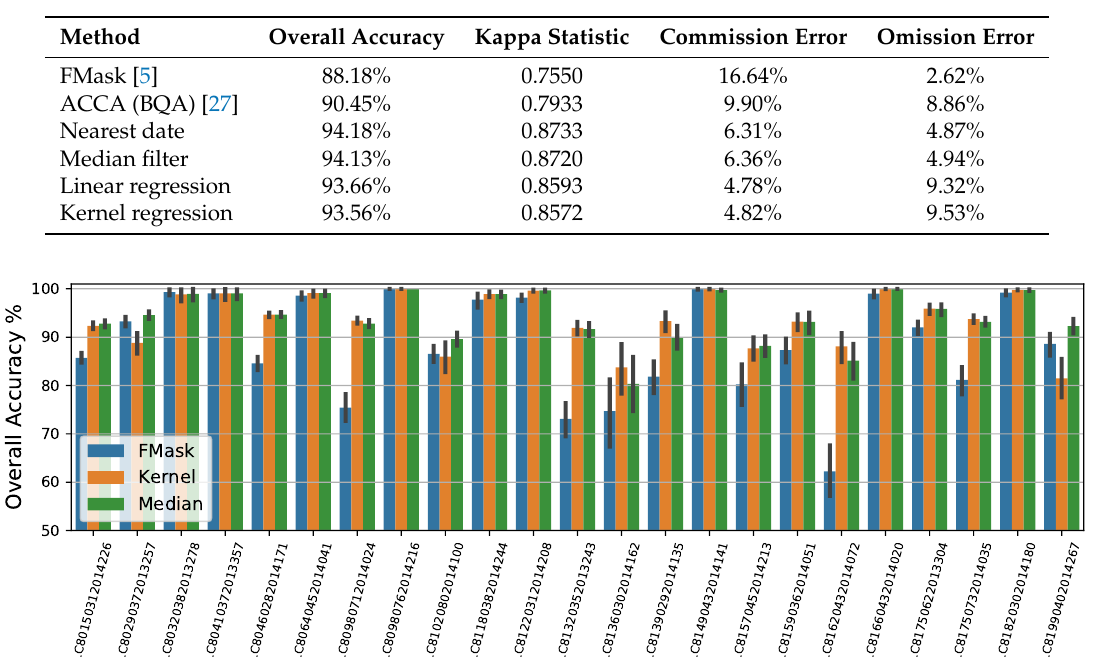
Table 2. Cloud detection statistics over all pixels of the used Landsat-8 Biome Dataset.